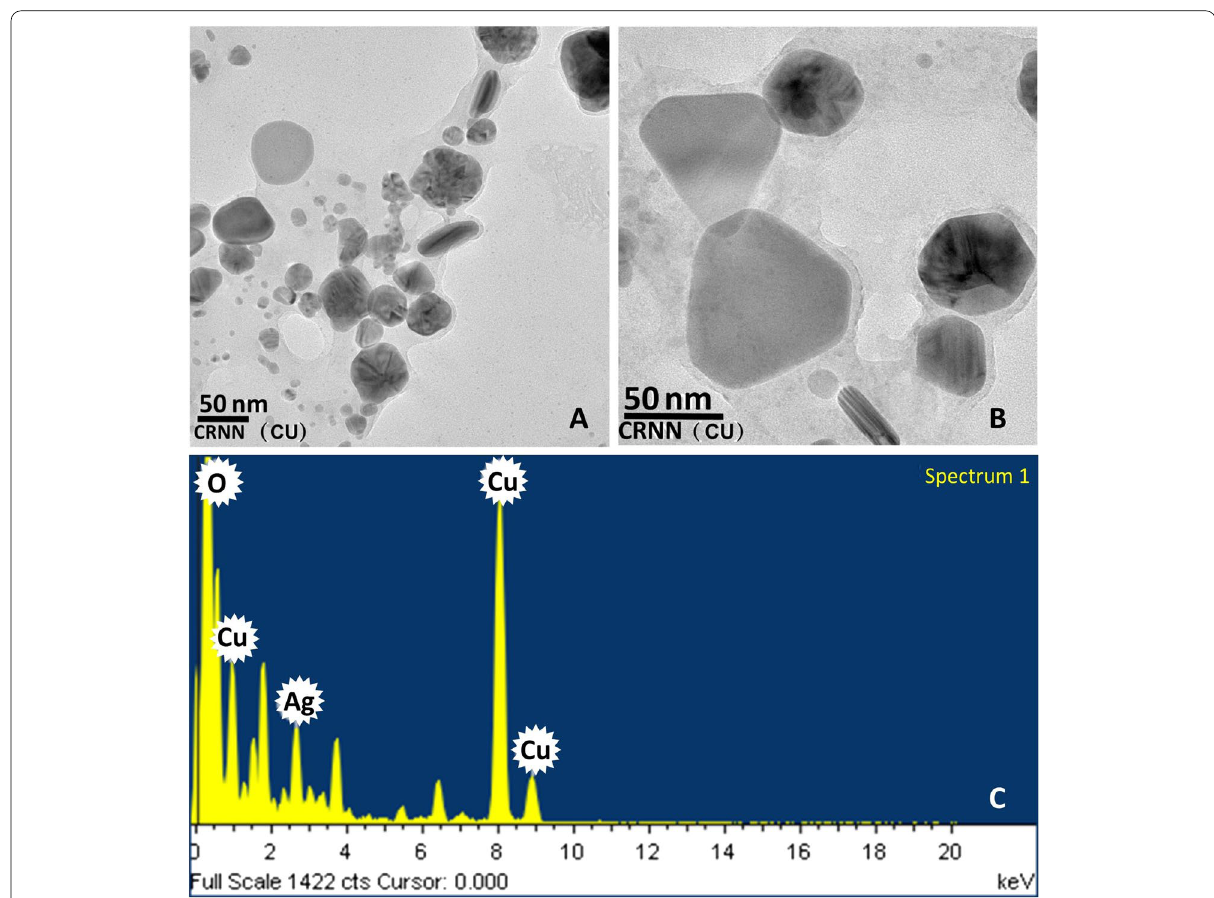
Fig. 3 HRTEM image of silver nanoparticle synthesized from Kaempferia angustifolia . A Size distribution of nanoparticles. B Shape distribution of nanoparticles. C EDS spectrum of silver nanoparticles shows the presence of